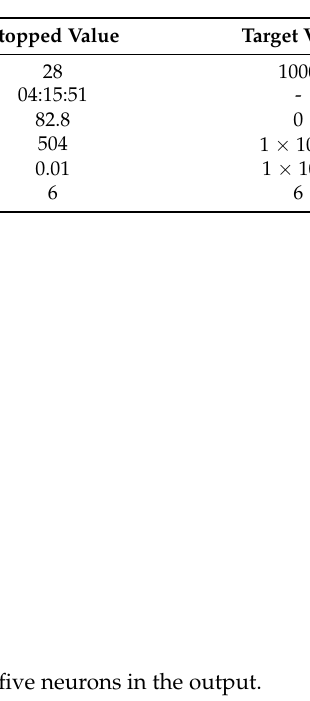
Table 9. Network training conditions.